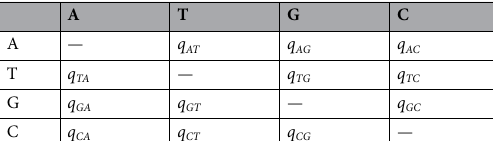
— = 1. π Q = 0 under the constraint ∑ π i ∈ { A , T , G , C } i